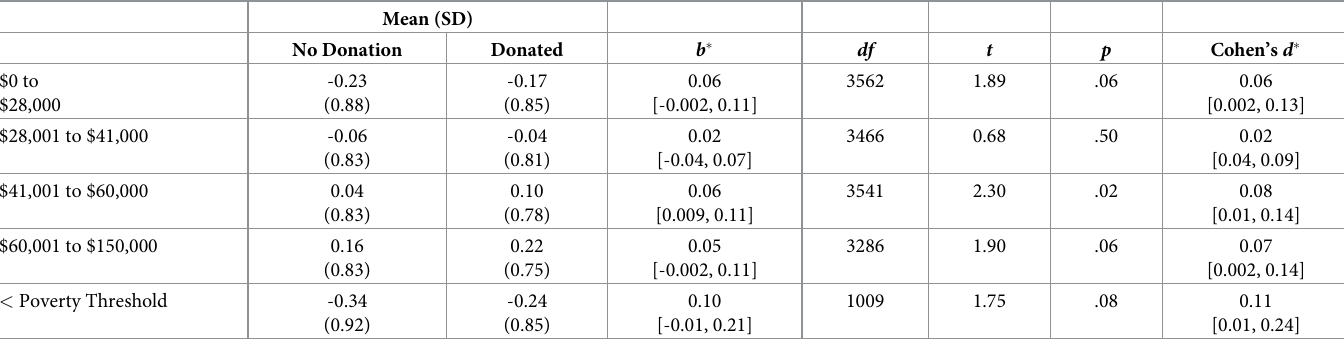
Table 5. The relationship between buying time and SWB by